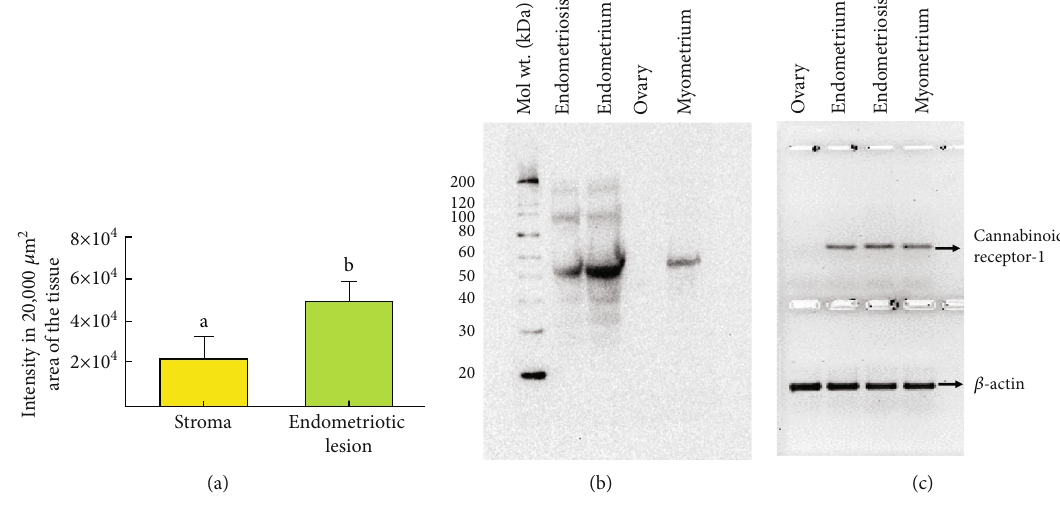
Figure 4: Expression of cannabinoid receptor 1 (CB1) in ovaries with endometriosis. Top panel : (a) intensity of expression of CB1 by endometriotic lesions in ovaries with endometriosis. Compared with the stroma, the intensity of CB1 expression is signi fi cantly higher in the epithelial cells in endometriotic lesions. Bars with di ff erent letters denote signi fi cant di ff erence between them ( P < 0 : 0001 ). Bottom panel : (b) CB1 protein expression: immunoblotting detected CB1 protein of approximately 50 kDa in tissue extracts from ovaries with endometriosis, endometrial, and myometrial extracts. In contrast, extracts from normal ovaries showed no expression for CB1. (c) Gene expression studies detected expression of CNR1 gene in all tissues examined except in normal ovarian